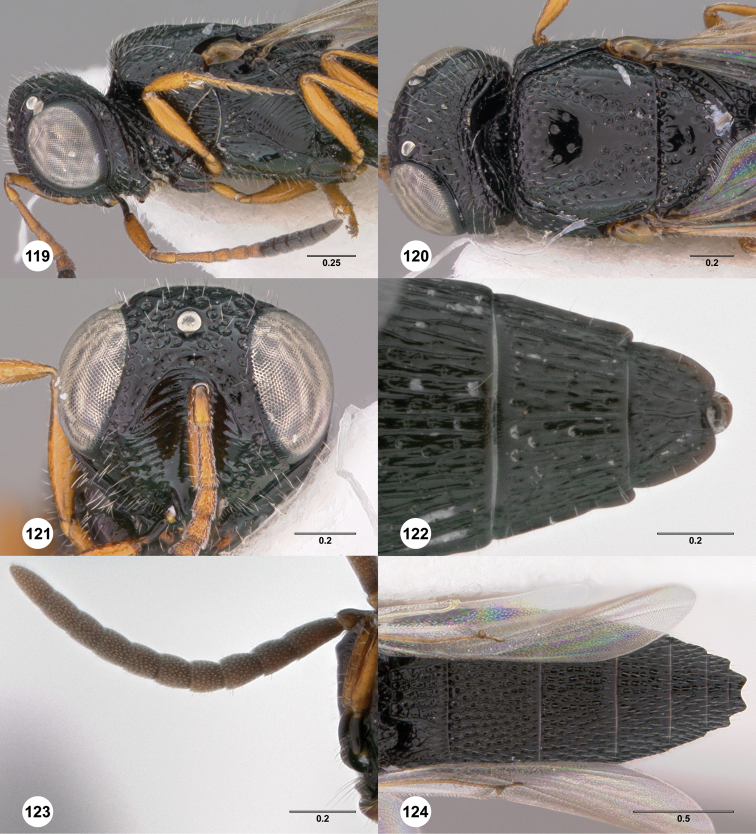
Oxyscelio funis sp. n., holotype female (OSUC 435969) 119 Head and mesosoma, lateral view 120 Head and mesosoma, dorsal view 121 Head, anterior view 122 Metasoma, dorsal view. Paratype male (OSUC 435980) 123 Antenna 124 Metasoma, dorsal view. Morphbank50